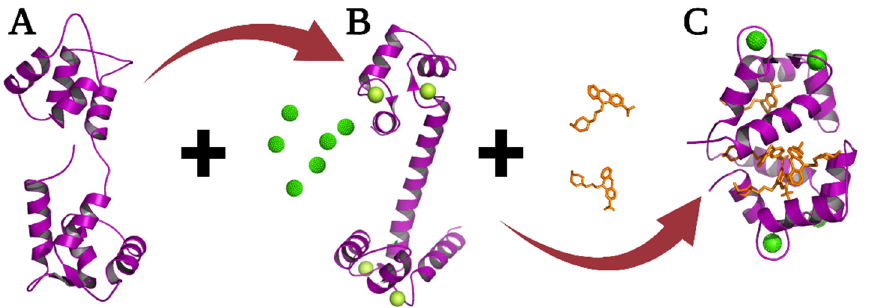
Figure 2. Structure three-dimensional models of the CaM in its three main conformations. Apo-CaM ( A ) was resolved by NMR (1CFD.pdb), Holo-CaM ( B ) with its four occupied binding sites shown in green spheres (1CLL.pdb), and the Ca +2 -CaM-TFP complex ( C ) corresponding to the closed form of the protein (1LIN.pdb).